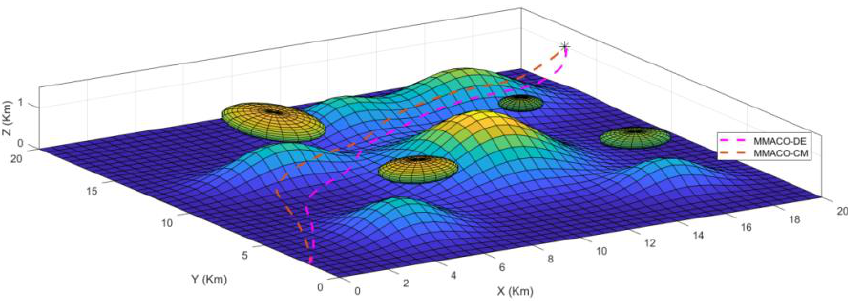
Figure 4. Case1; 3D view of path followed by UAV1 and UAV2 to the target (*).